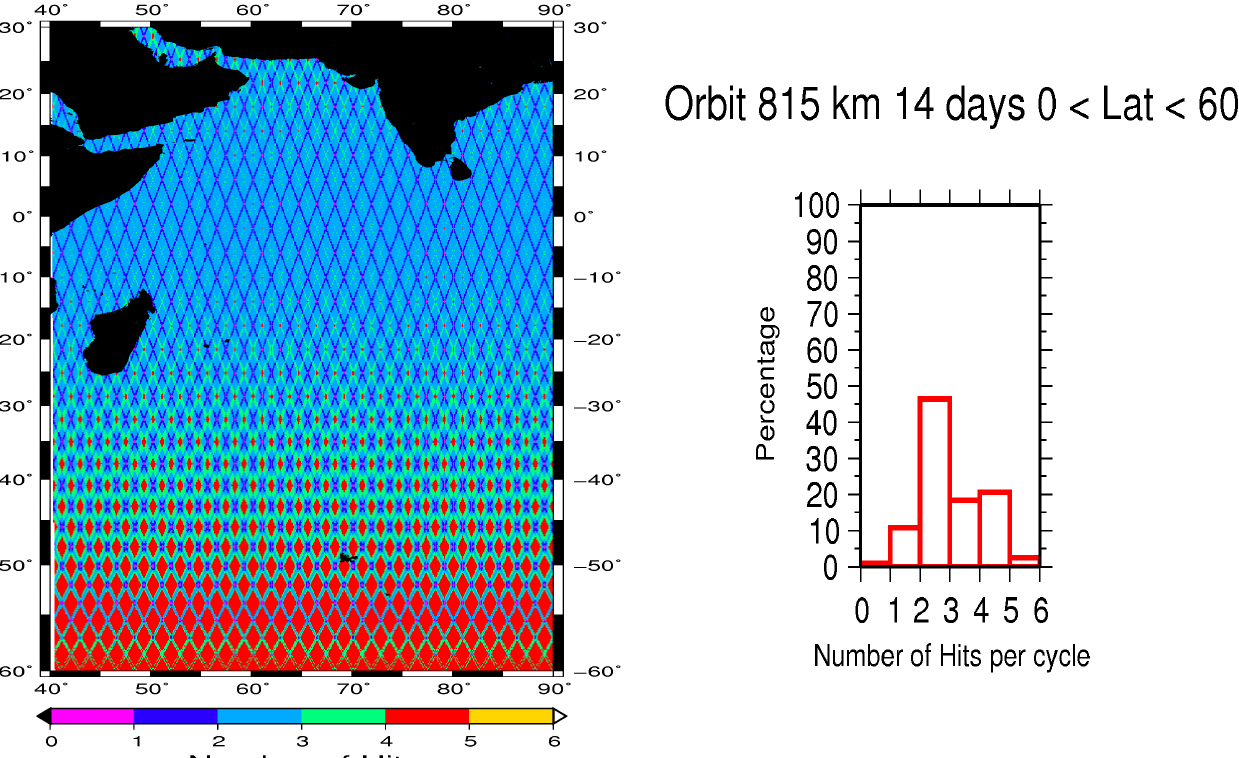
Figure 22. (a) Number of Hits per cycle of repeatability for a 815 km sun-synchronous orbit over the Indian Ocean (b) Temporal coverage of this orbit between 0 and 60 degrees